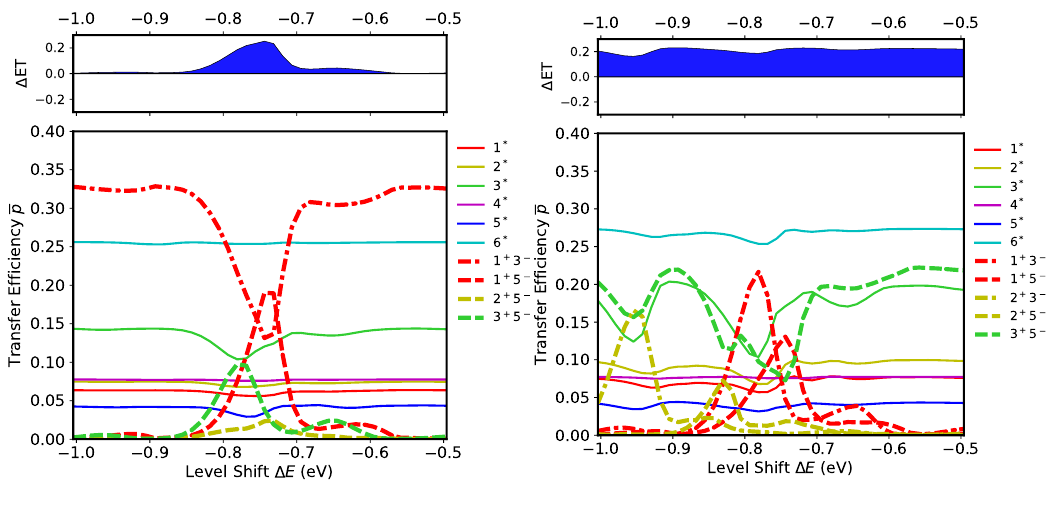
Figure 8. Transfer efficiencies and ∆ ET with τ = 1ps at 77K. CT states whose transfer efficiencies are less than 0.02 are not displayed. ∆ E m = 0 for m = 2, 4, 6. ( a ) The level shift ∆ E 5 varied while ∆ E = − 2900cm − 1 . ( b ) The level shift ∆ E 3